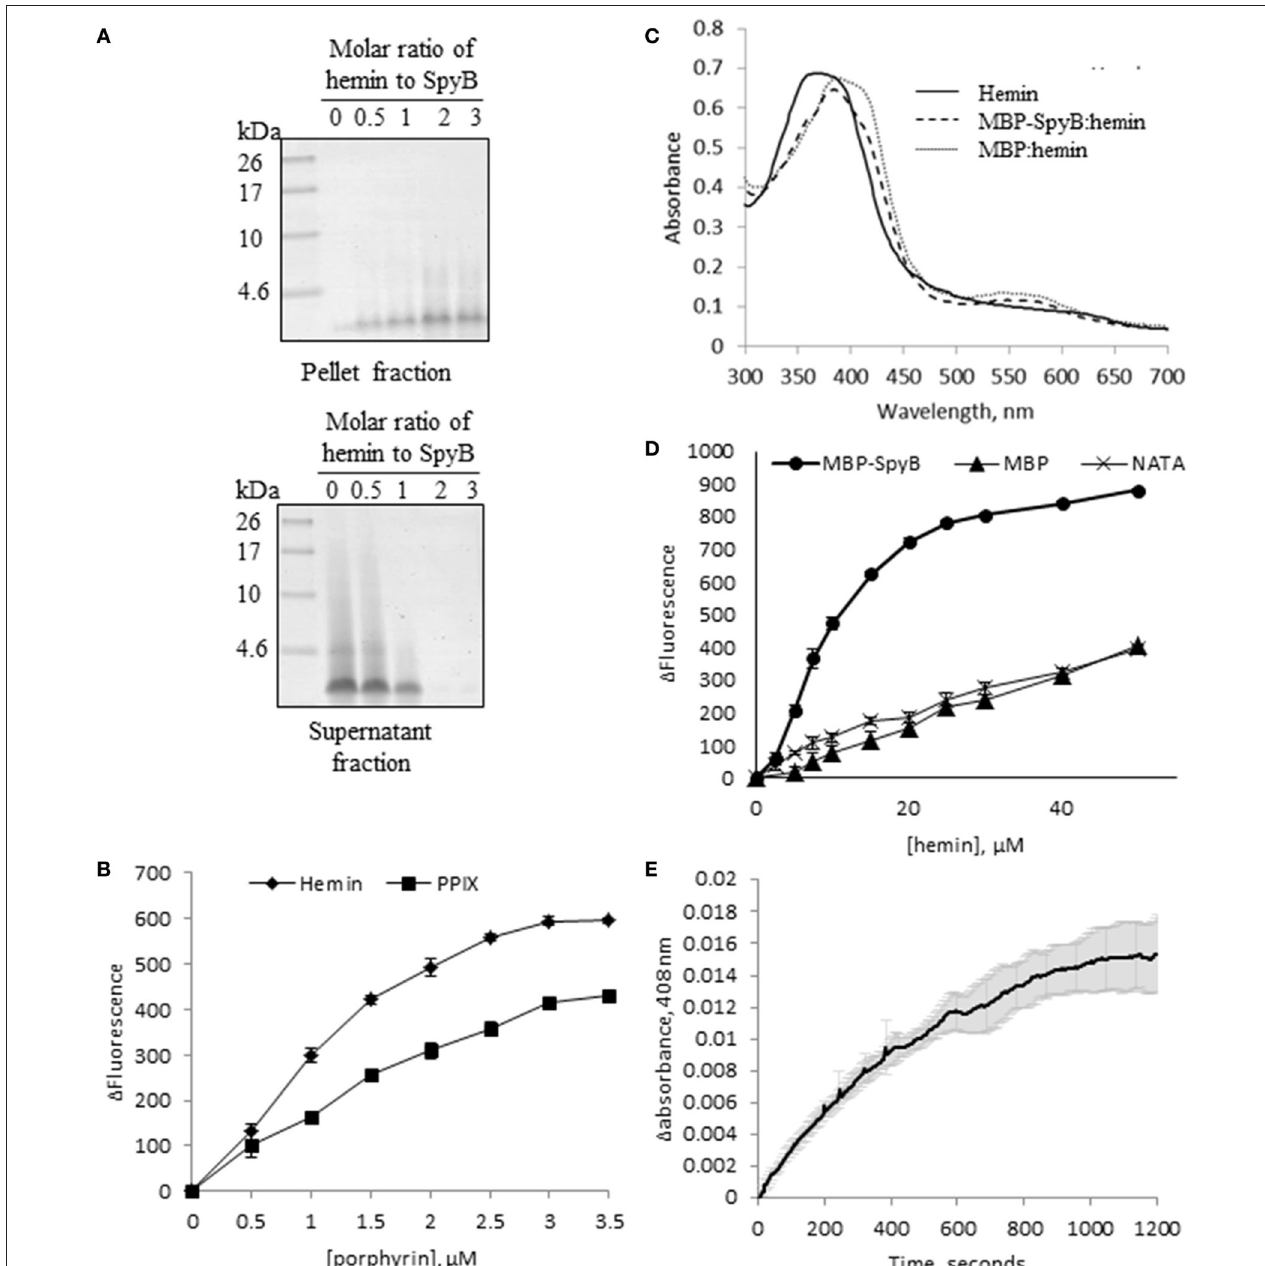
FIGURE 5 | SpyB is a porphyrin-binding protein. (A) Hemin binding decreases SpyB solubility. SpyB was mixed with hemin in different molar ratios. Soluble and insoluble fractions were separated by centrifugation and resolved on a 16% Tris-Tricine gel. (B) The change in tryptophan fluorescence quenching of SpyB by hemin and protoporphyrin IX (PPIX). A series of hemin or PPIX concentrations (0, 0.5, 1, 1.5, 2, 2.5, 3, and 3.5 µ M) was added to 5 µ M SpyB, in the presence of 1 mM DTT. The curves are the average of three replicates ± standard deviation. The dissociation constant (K D ) was calculated using SigmaPlot software. (C) Absorbance spectra between 300 and 700 nm were collected for 50 µ M hemin; 50 µ M hemin mixed with 2.5 µ M MBP-SpyB; and 50 µ M hemin mixed with 2.5 µ M MBP, in the presence of 1 mM DTT. (D) The change in tryptophan fluorescence quenching for MBP-SpyB and MBP. A series of hemin concentrations (0, 2.5, 5, 7.5, 10, 15, 20, 25, 30, 40, 50 µ M) was added to 2.5 µ M MBP-SpyB monomer or MBP, in the presence of 1 mM DTT. A control experiment was performed with 27.5 µ M N-acetyltryptophanamide (NATA) under the same conditions. The curves are the average of three replicates ± standard deviation. The K D was calculated